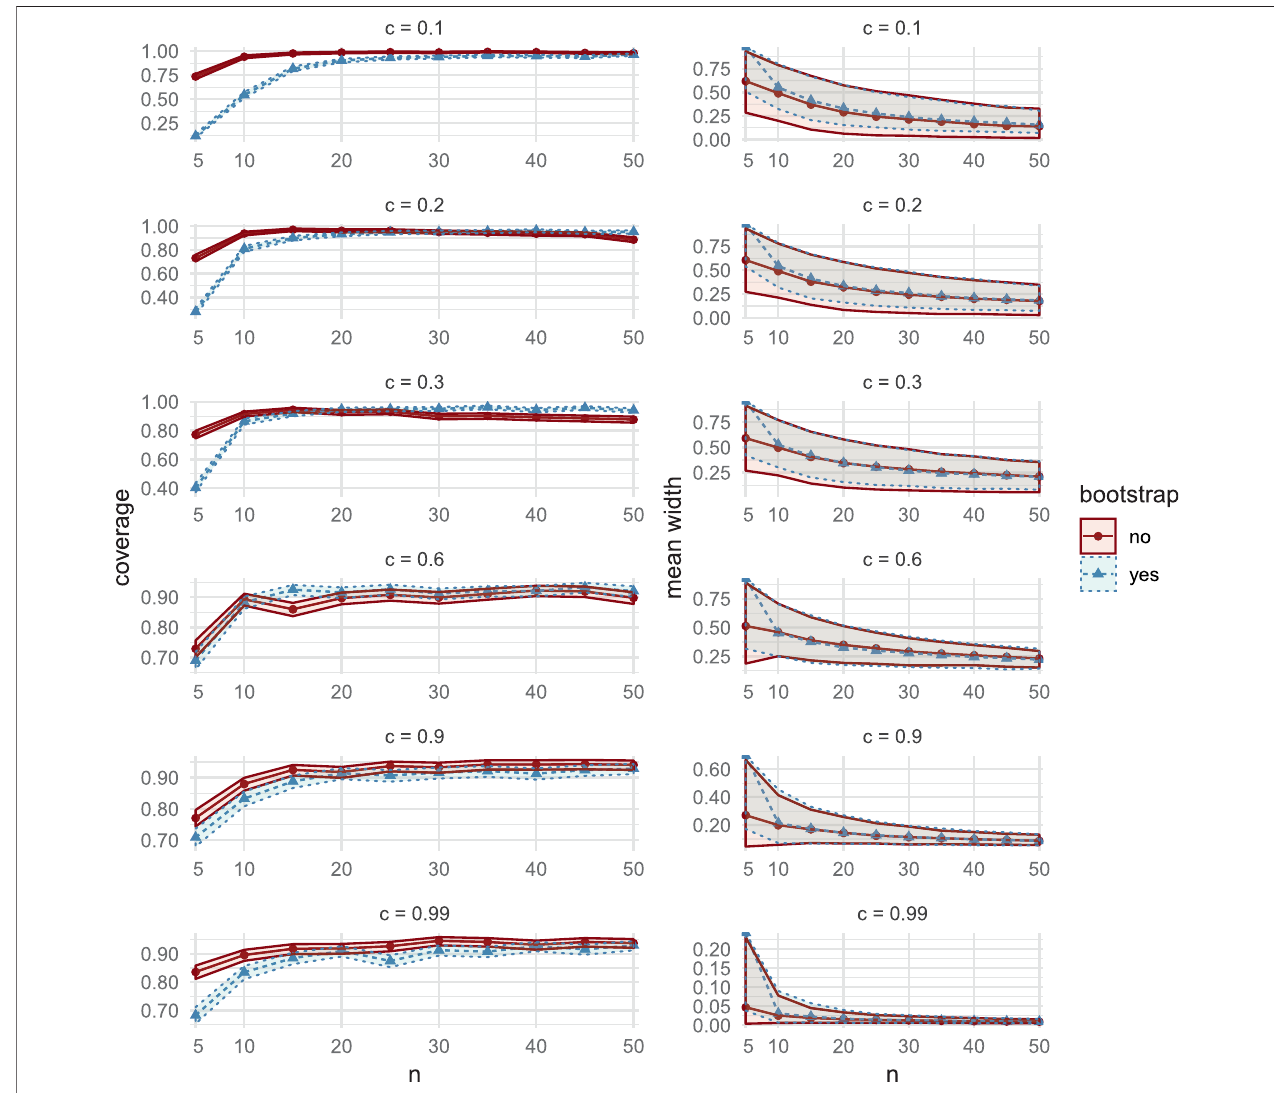
FIGURE 13 | Comparisons of coverage (left column) and mean width (right column) , between the bootstrap CIs (dashed lines with triangular markers) and the asymptotic CIs (solid lines with circular markers) in MC Study B. Rows represent correlations c, increasing from 0:1 on the top row to 0:99 on the bottom row. The horizontal axes display the sample sizes n (cid:2) 5;